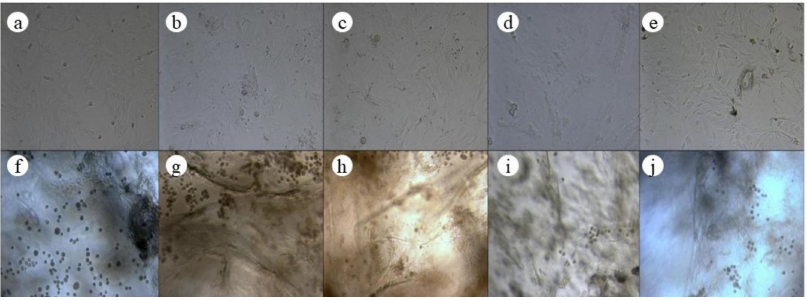
Figure 4. Microscopic images of ADSCs at different times ( a – e : the jawbones scaffold group; f – j : the control group) ( ×